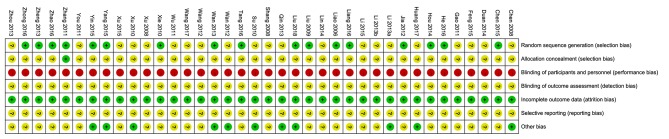
Risk of bias of each study.